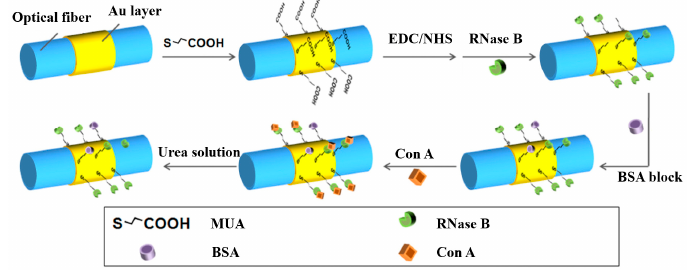
Figure 3. Functionalization and detection procedure of the SPR sensor.